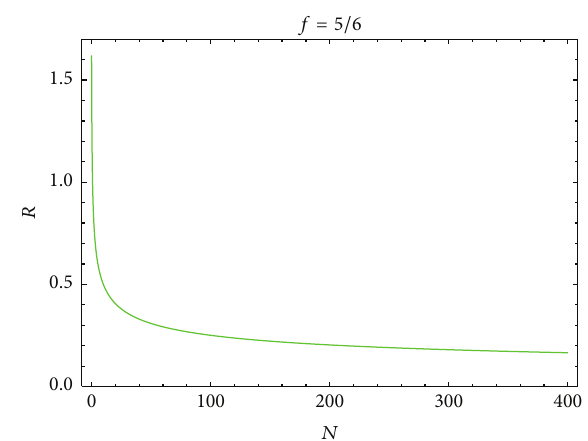
Figure 7: In this graph we plot the scalar-tensor ratio 𝑅 in terms of the number of e-folds 𝑁 . We can find best range of tensor-scalar ratio, where 60 < 𝑁